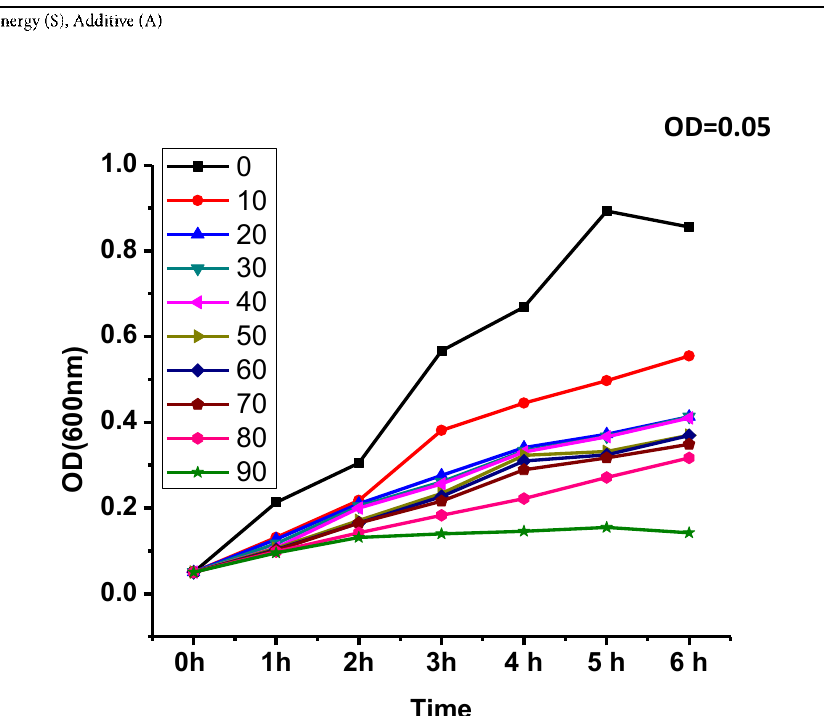
Fig. 8. The image represents the time dependent effect of silver nanoparticles on the growth of S. Typhi bacteria.